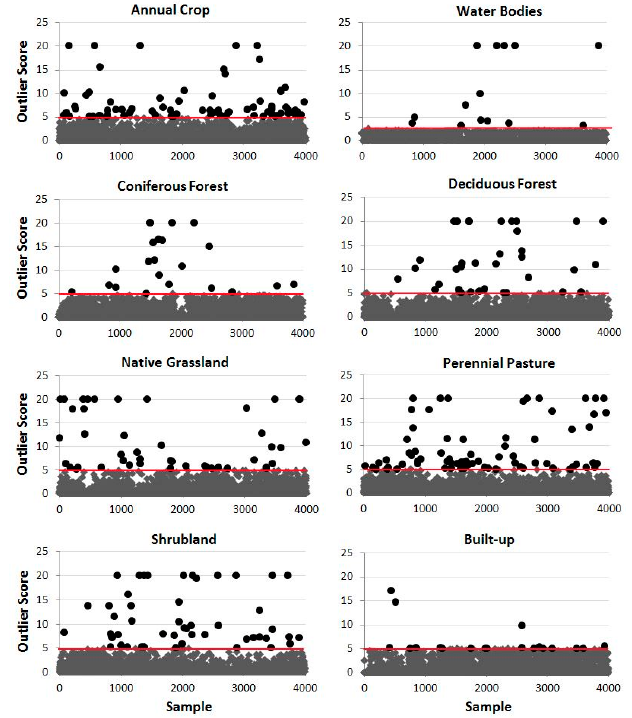
Figure 2. Random Forests’ outlier score distribution of year 2000 samples used for year 2001 modelling: Black circles: identified outliers; line in red (threshold): outliers are located above the line.